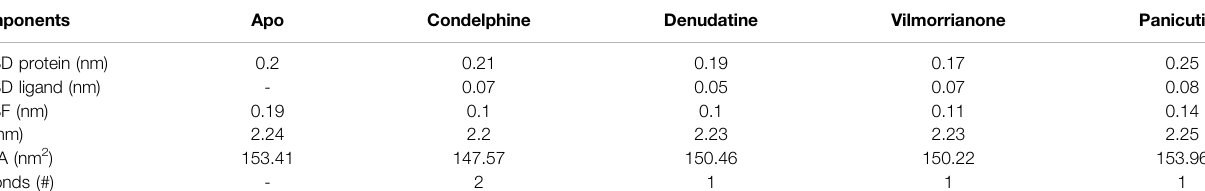
TABLE 3 | Calculated values of different components of MD simulations such as protein backbone RMSD, ligand RMSD, RMSF, Rg, SASA, and H-bonds. Components